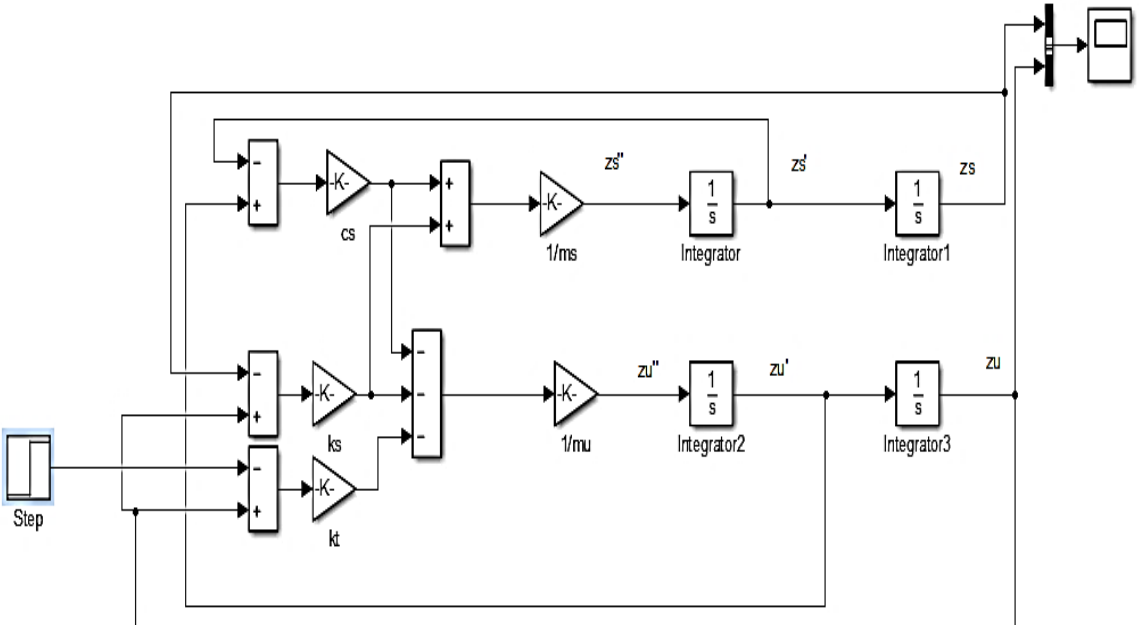
Figure 8. Simulink block diagram for quarter car model